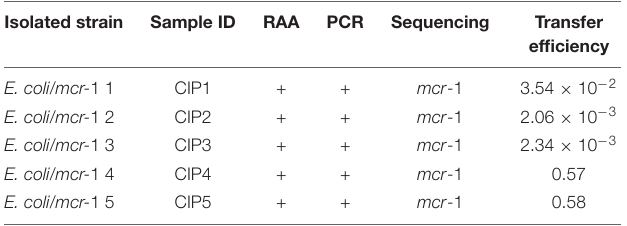
TABLE 3 | mcr -1-Positive Strains isolated from clinical samples. Isolated strain Sample ID RAA PCR Sequencing Transfer